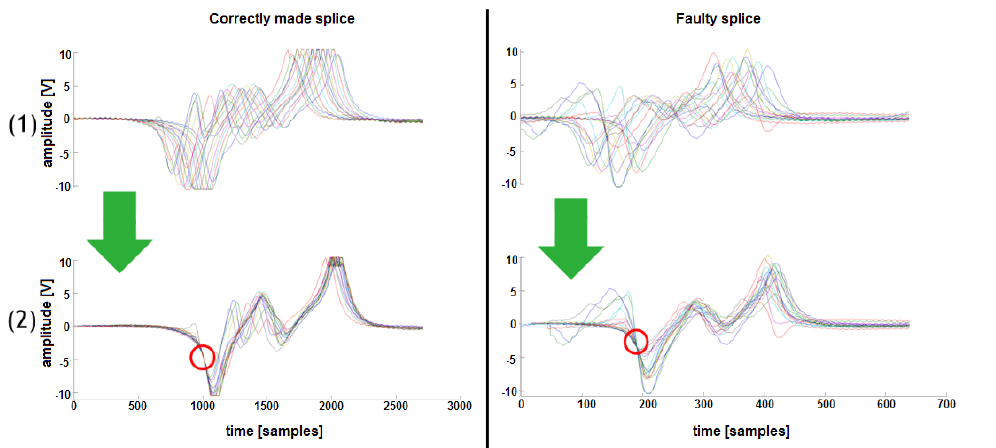
Figure 13. The results of synchronization performed with a single-point algorithm for a correctly made splice (on the left) and for a faulty splice (on the right) with the synchronization point marked (red